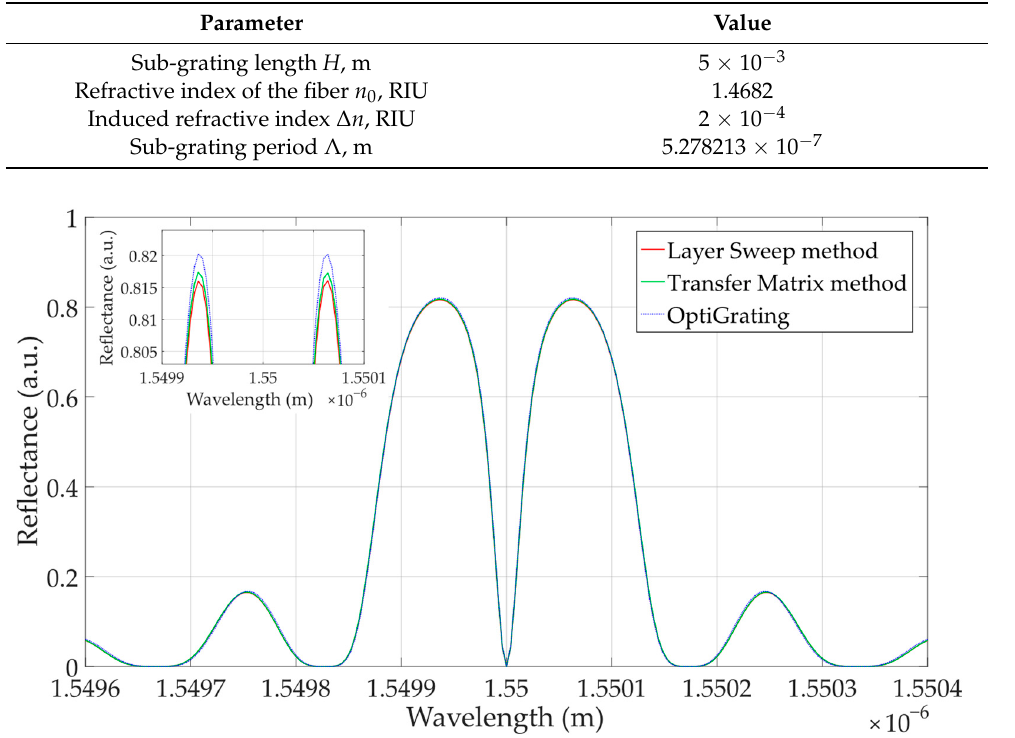
Table 2. Modeling parameters of the π -phase-shifted FBG.